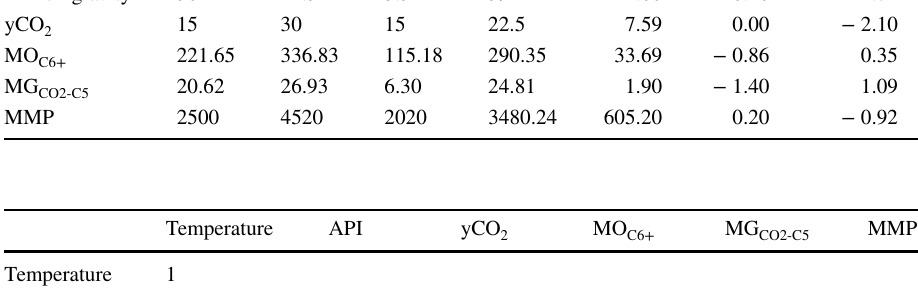
Table 2 A statistical analysis of the input and output data used in this study